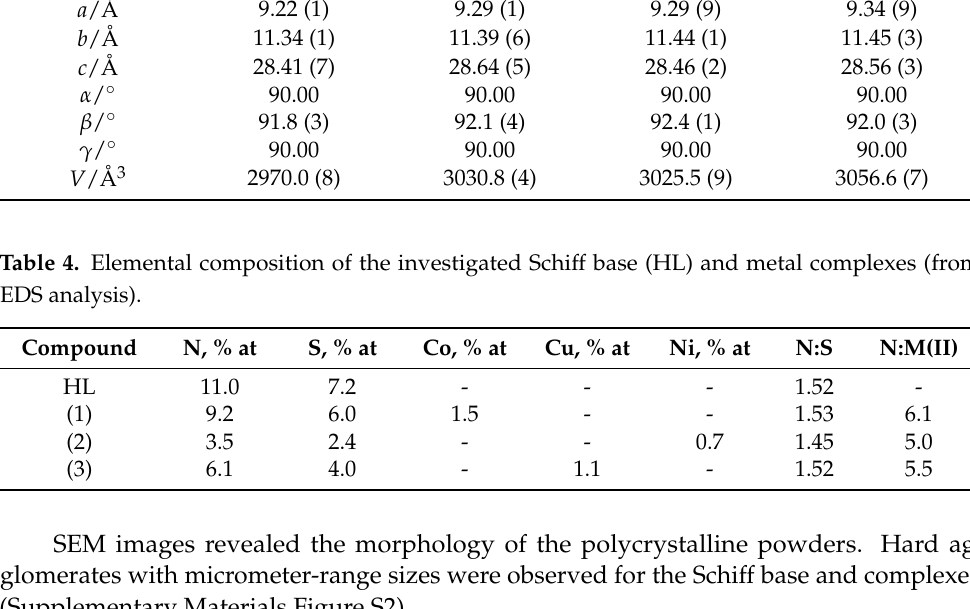
Table 3. Structural parameters of the Schiff base (HL) and metal complexes (1 – 3) .